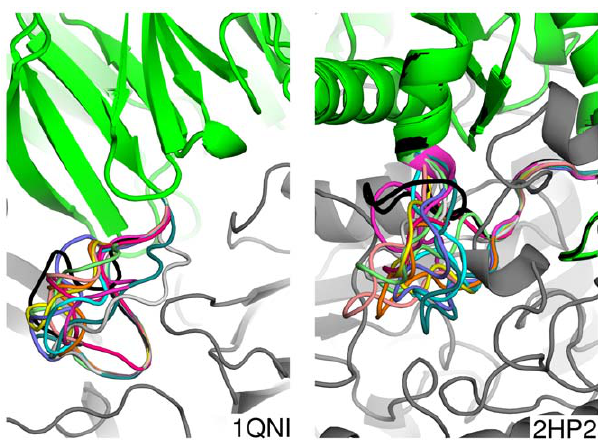
Figure 7. Poorly predicted 1qni and 2hp2 loops. This figure shows the insufficiency of AnchoredDesign’s loop predictions for 1qni and 2hp2. In gray is the nonmoving side of the interface and in black is the correct structure. Each of the ten colors represents the loops of one of the top ten predictions by lowest energy. The predictions’ protein cores are green. Notice that the loops themselves do not converge, but that the rigid-body placement and interface as a whole is correct (the green and black portions are overlaid towards the top of each panel).